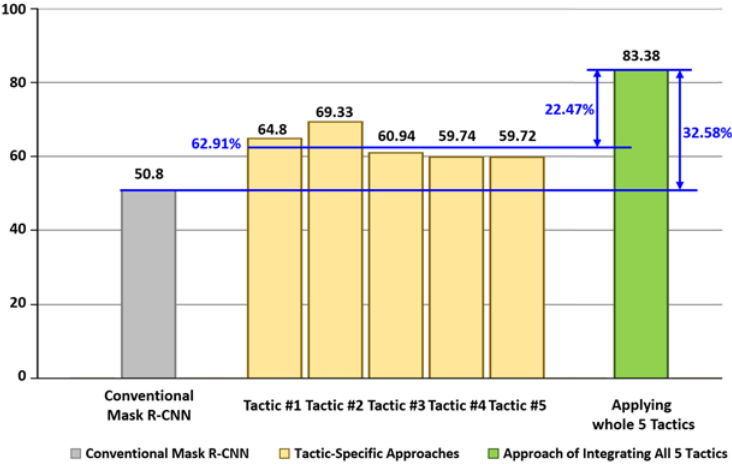
Figure 18. Comparing performances of segmentations with- and without discarding false segmentation.